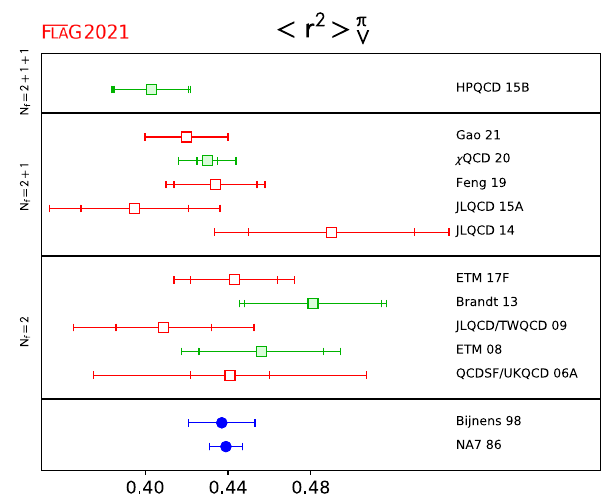
Fig. 17 Summary of the pion form factor (cid:17) r 2 (cid:18) π